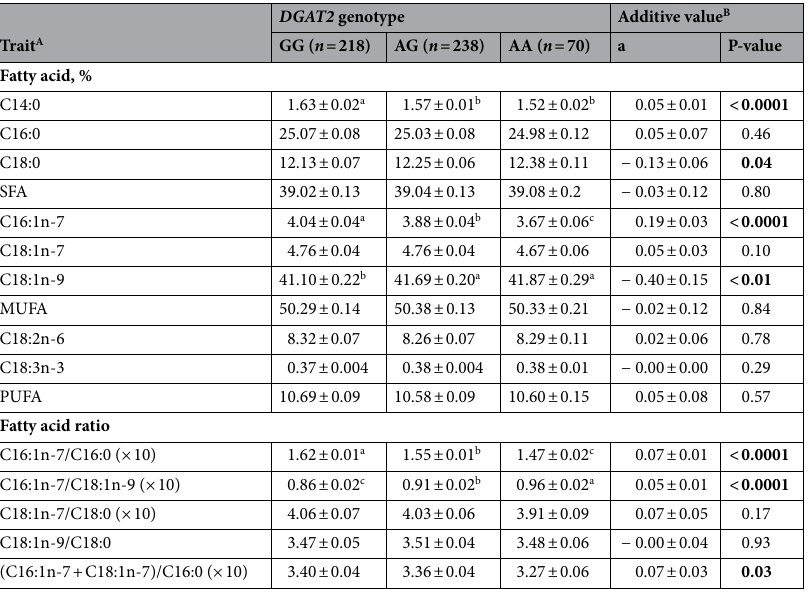
Table 3. Least square means and additive values (± standard errors) for fatty acids content and fatty acid ratios in longissimus dorsi by DGAT2 genotype. A SFA: saturated fatty acids (C14:0 + C16:0 + C18:0 + C20:0); MUFA: monounsaturated fatty acids (C16:1n-7 + C18:1n-9 + C18:1n-7 + C20:1n-9); and PUFA: polyunsaturated fatty acids (C18:2n-6 + C18:3n-3 + C20:2n-6 + C20:4n-6). B Additive allele substitution of G for A. a,b,c Within trait, means with different superscripts differ significantly (P < 0.05). Bold font indicates statistical significance.